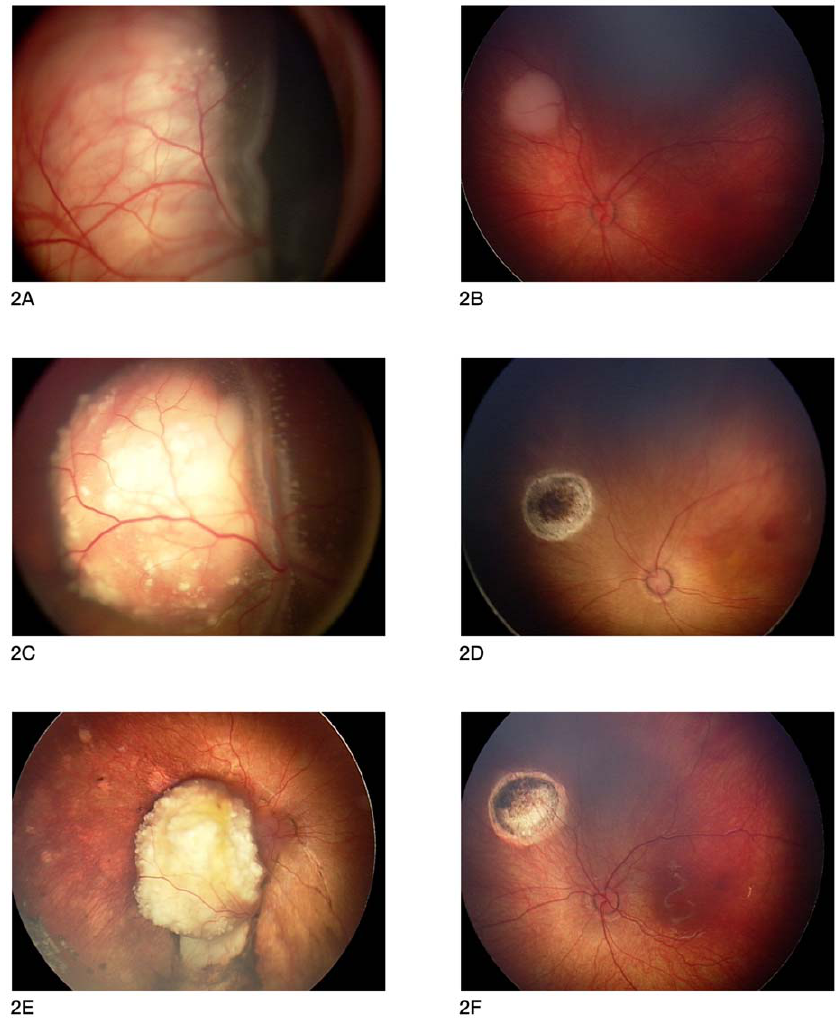
Figure 2. Two-week old female with bilateral retinoblastoma treated with bridge IV-IA chemotherapy. Figure 2A & 2B: Fundus photographs at initial examination (2 weeks of age). 2A: right eye: large tumor with total retinal detachment. The eye was classified Reese-Ellsworth group 5A and International classification of Retinoblastoma Group D. 2B: left eye: small tumor. The eye was classified Reese-Ellsworth group 1A and International classification of Retinoblastoma Group B. Figure 2C & 2D: Fundus photographs after 4 cycles of intravenous (IV) carboplatin chemotherapy (4 months of age). 2C: right eye: the tumor has partially regressed, the retina is still totally detached and subretinal seeds are visible. 2D: left eye: complete tumor regression with laser treatment. Figure 2E & 2F: Fundus photographs at 9 months of age, after one right ophthalmic artery IA (intra-arterial) chemotherapy performed at 4 months of age. 2E: right eye: the tumor has shrunk and calcified (Type 1 regression), with disappearance of the subretinal seeds. The retina has reattached. Final electroretinogram (ERG) was fair. 2F: left eye: white scar (Type 4 regression). Final ERG was good.